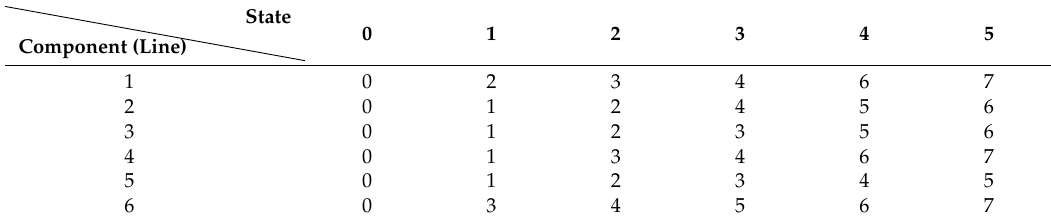
Table 7. The weights/performance of each component in each